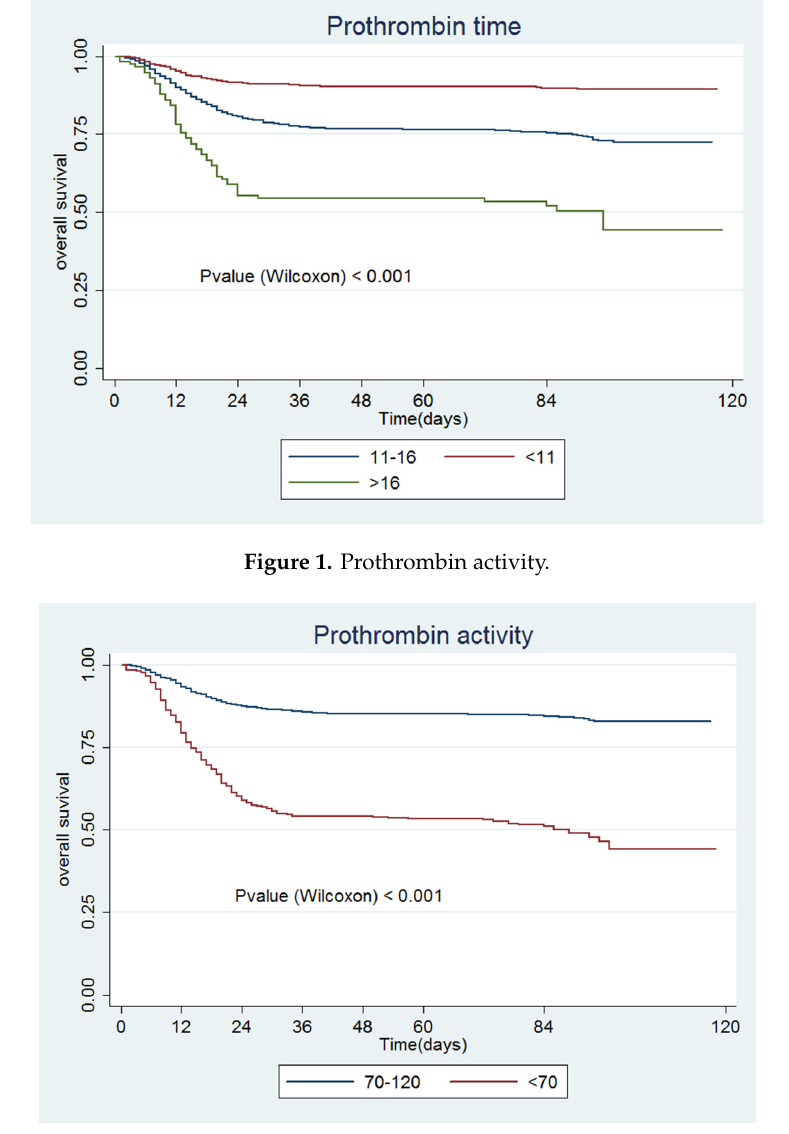
Figure 2. Prothrombin activity.